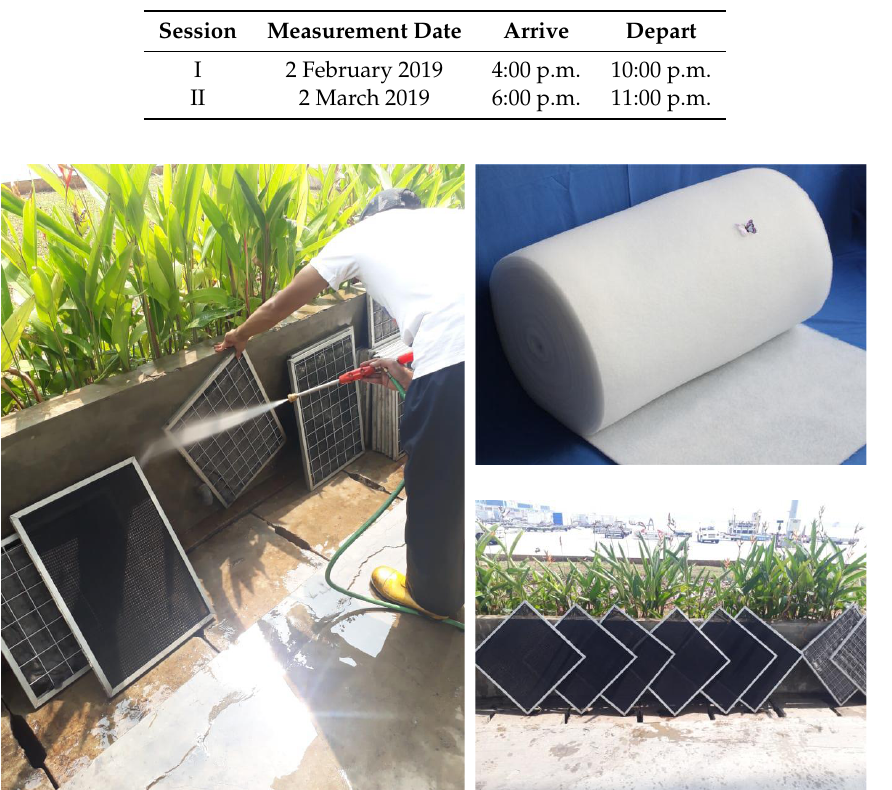
Figure 4. Filters being cleaned at the